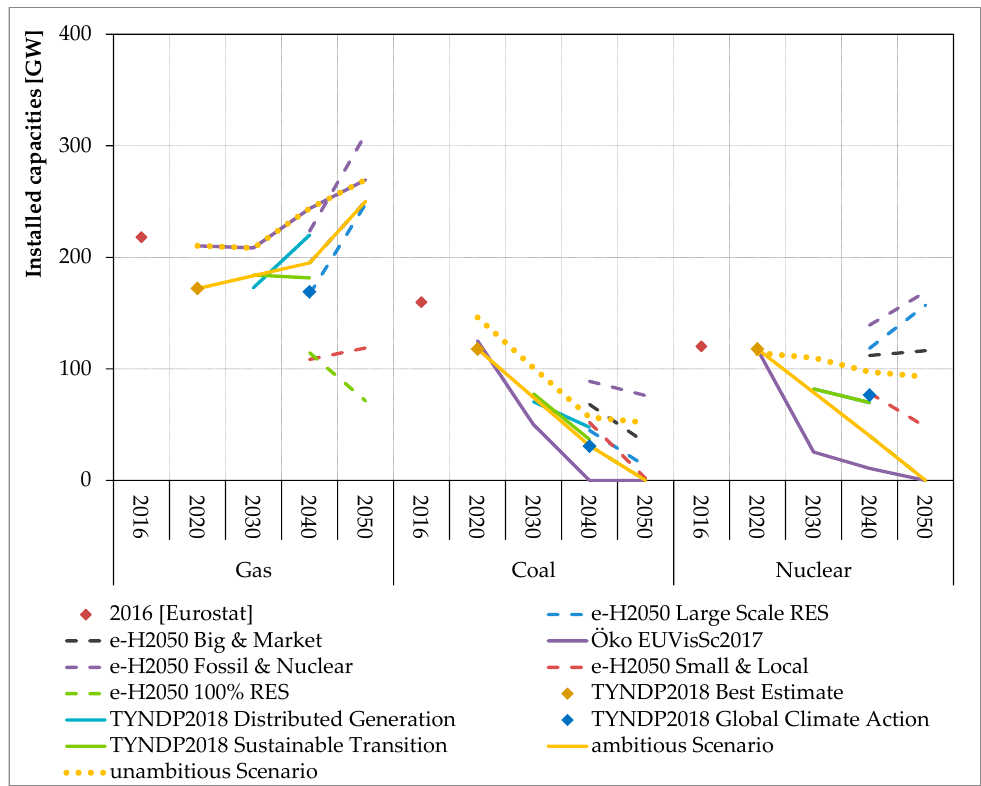
Figure 16. Conventional generation capacities installed in EU 28 countries. Sources: References [5,29–31].